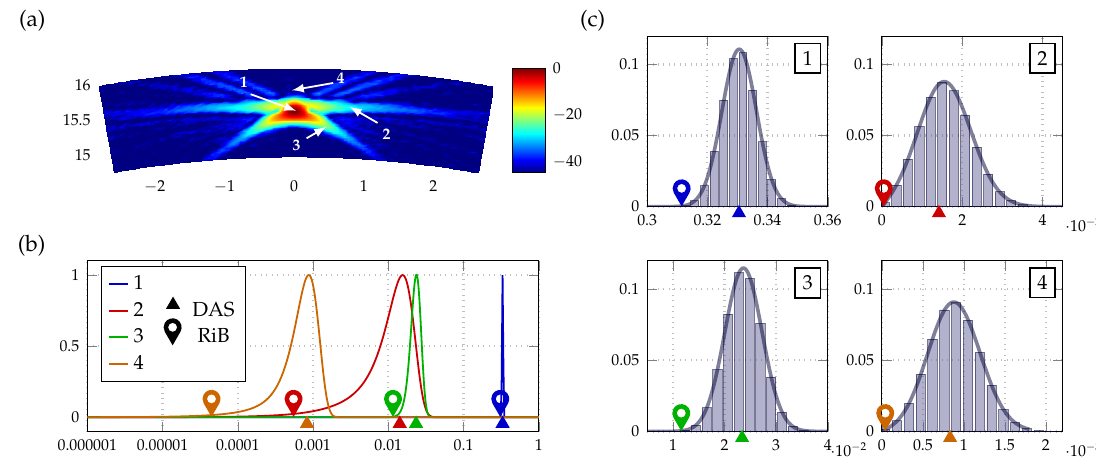
Figure 2. Z p random variable behaviour in presence of a point source. ( a )PSF-DAS and ( b )probability density function, standardised with respect to the maximum value ( c ) Z p fitting to